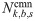
Ambiguity analysis of integrative single-step perturbation.The analysis is performed for the D and the DO perturbations in integration with different types of omics data over all Boolean functions and all initial states for k = 2, 3, and 4. A: One of the sources of the ambiguity in logic-based GRN inference is that the set of the transitions in the SPSD due to the perturbations is common between Nk,b,scmn number of the Boolean functions, which only one of them is the real one. The average value of Nk,b,scmn over all values of b and s is displayed for different values of k. B: The probability of unambiguity (Pua) for integrative single-step perturbation.